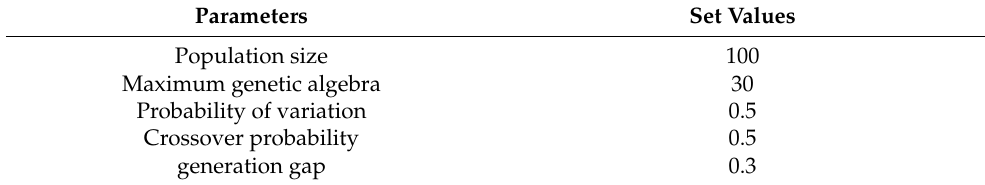
Table 4. Genetic algorithm